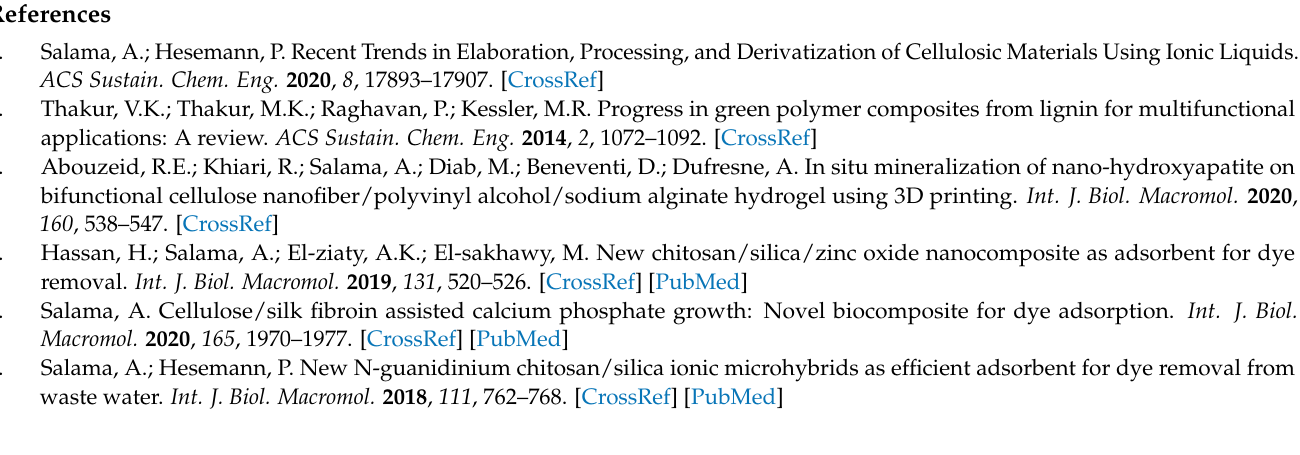
section. Figure S12: Artwork of silver nanoparticles formation on the bacterial cellulose matrix (Pal, Nisi, Stoppa, & Licciulli, 2017). Figure S13: UV-vis spectra of CNF–AgNPs mixed with 20 different amino